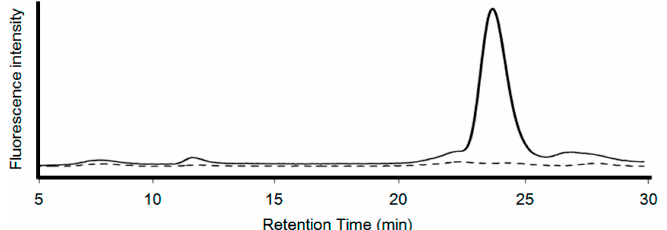
Figure 7. The extracts from F. oxysporum after ultrasonication were subjected to gel filtration chromatography using a TSKgel G2000SWXL (7.8 mm × 300 mm, TOSOH). Elution was performed with a 50 mM ammonium acetate buffer solution (pH 5.7) at a flow rate of 0.6 mL/min and monitored by measuring fluorescence at excitation 310 nm/emission 410 nm. Black line: 5 mM Cd (+) Se IV (+) solution (pH 7.5) at 25 °C treatment. Black broken line: Negative control without treatment of cadmium and selenium solution.